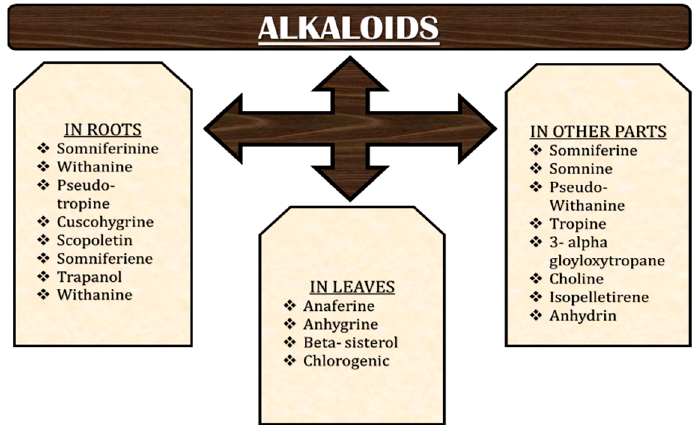
Figure 7. Various alkaloids present in different parts of W. somnifera .